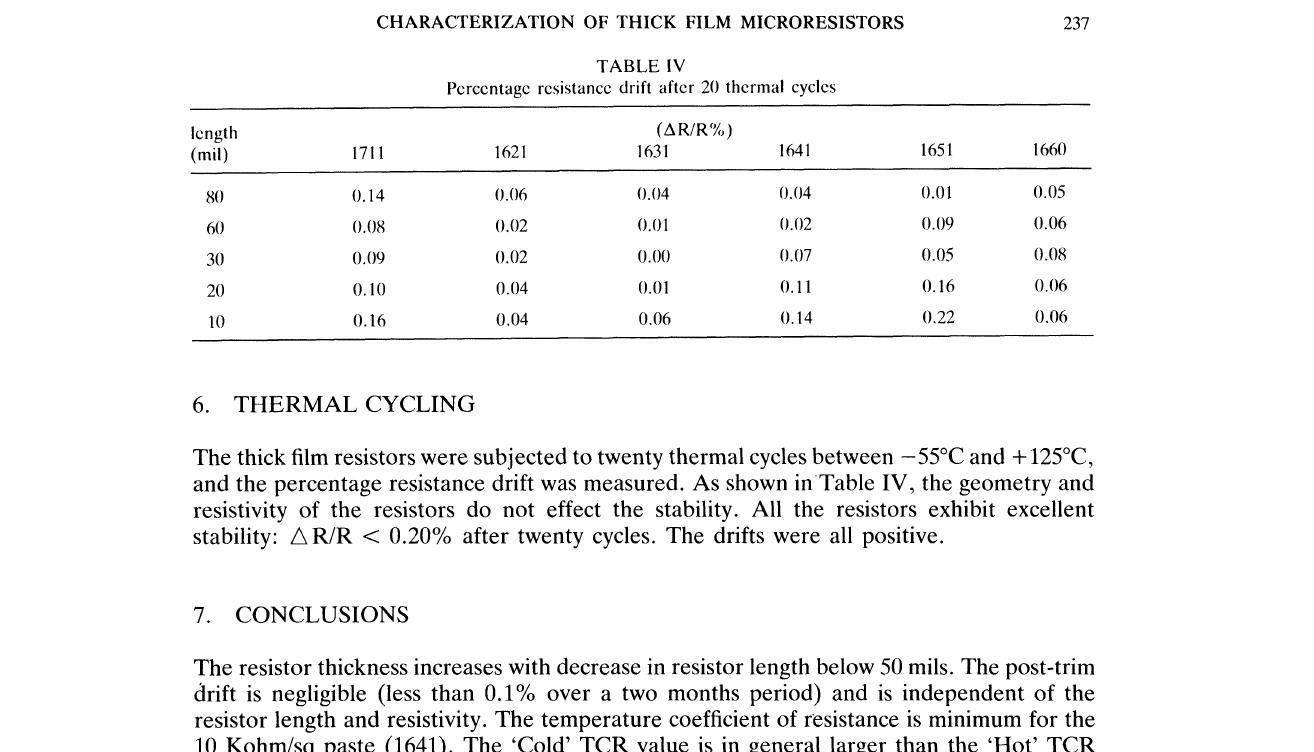
TABLE IV Pcrccntagc resistance drift after 20 thermal